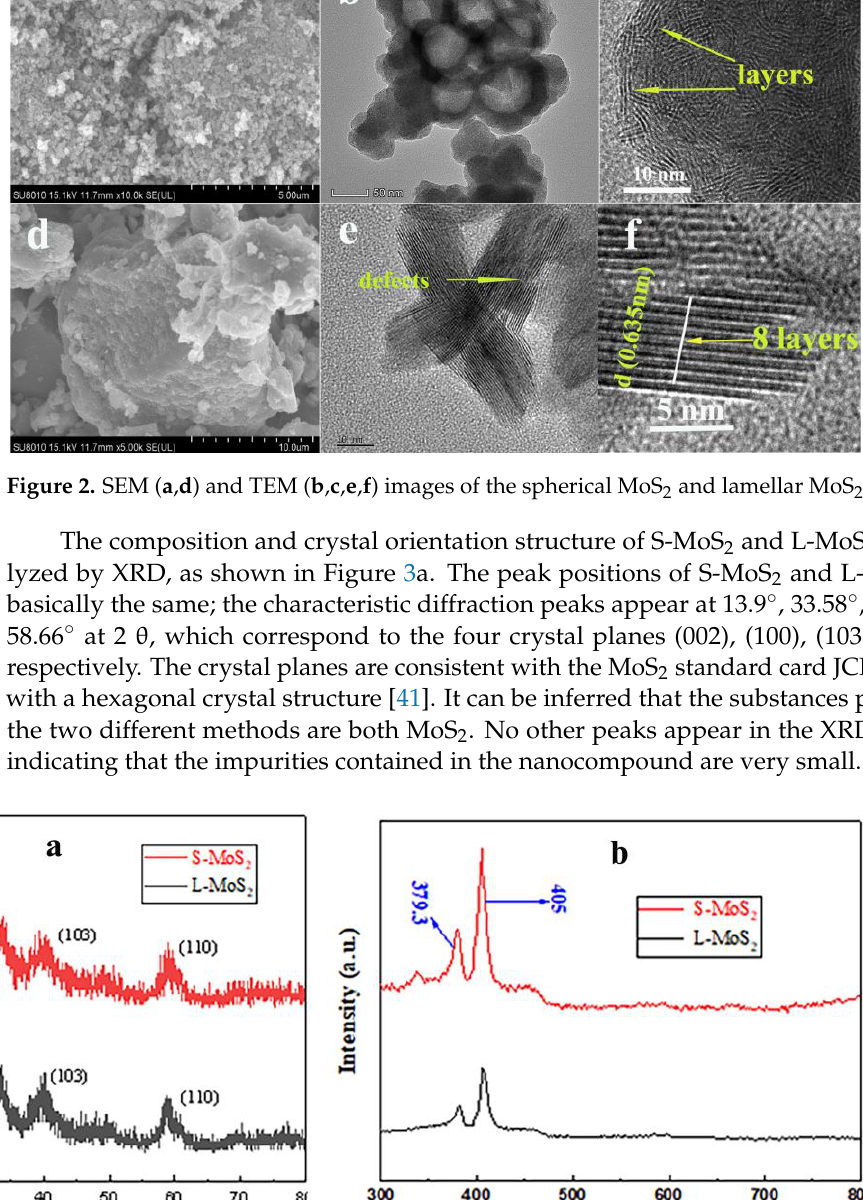
Figure 3. XRD ( a ) and Raman ( b ) spectra of the S - MoS 2 and L - MoS 2 .